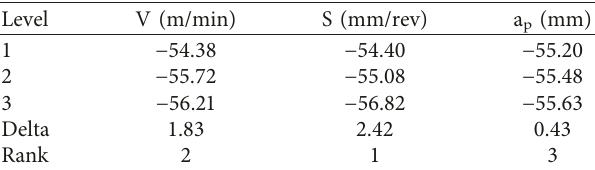
Table 6: Signal-to-noise ratio for Θ ° C: response